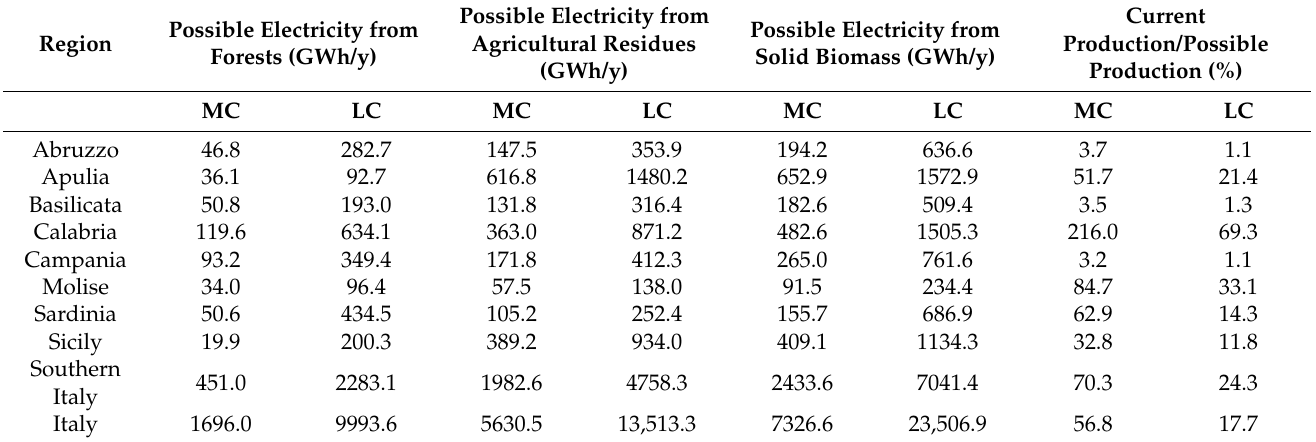
Current Production/Possible Production